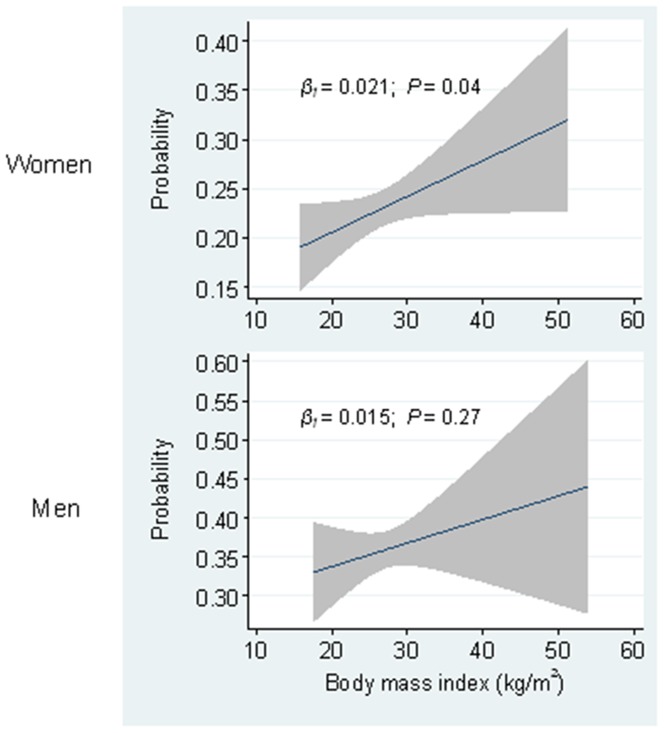
Probability of Staphylococcus aureus colonization.Probability of S. aureus carriage among women (n = 2,169) and men (n = 1,709) according to body mass index in kg/m2. Lines depict regression line (navy) with 95% mean prediction interval (grey area) from age-adjusted linear regression models.